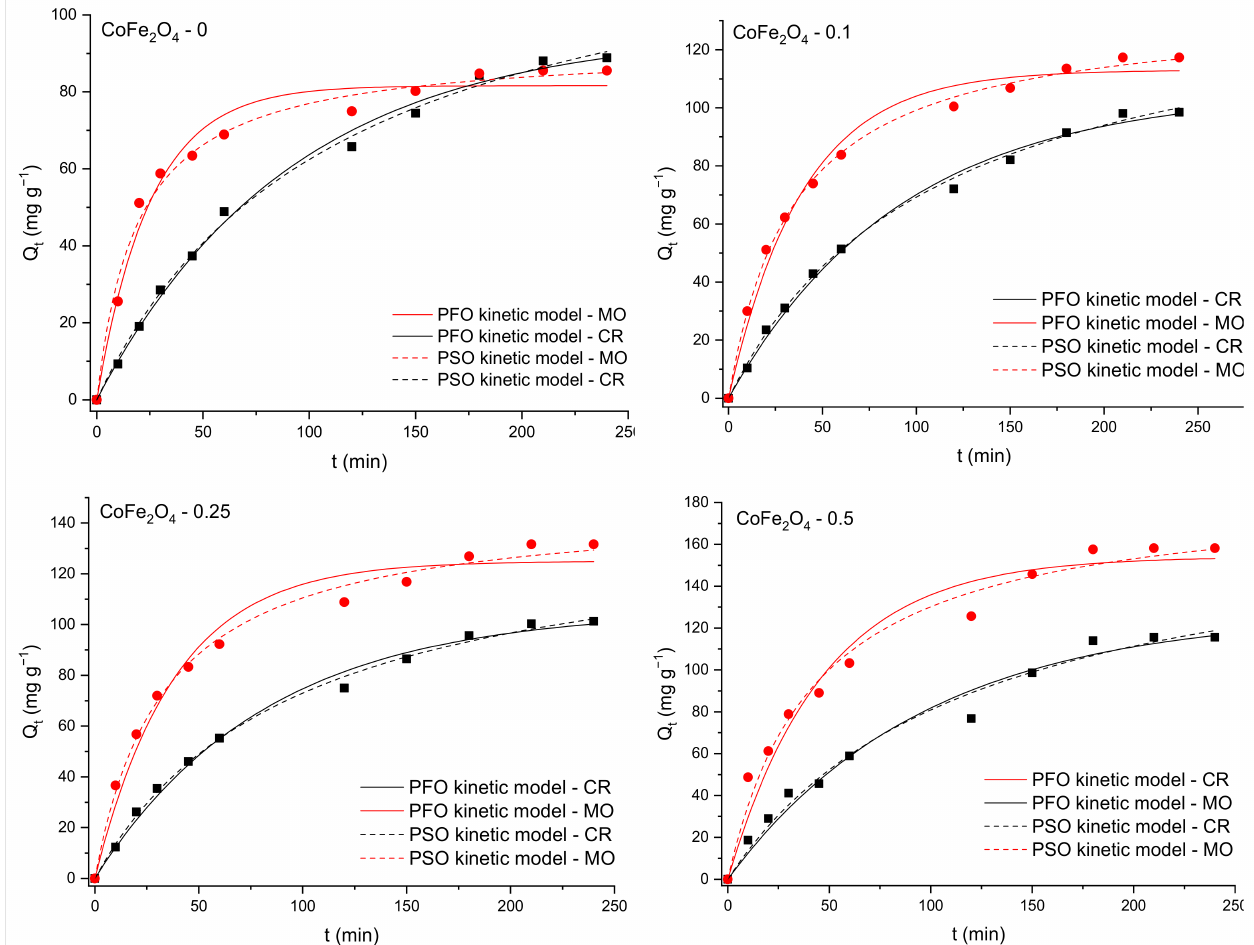
Figure 15. Graphical representation of the PFO and PSO kinetic models for removal of CR and MO by adsorption onto CoFe 2 O 4 samples from binary solutions (nonlinear